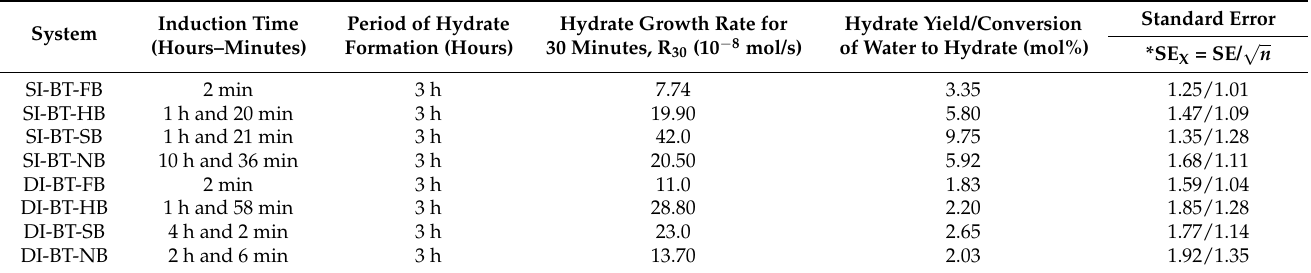
Table 1. Outcomes of single and dual-impeller experiments (* where SE is the standard deviation and n = 2 the number of experiments while the results are for 1 and 600